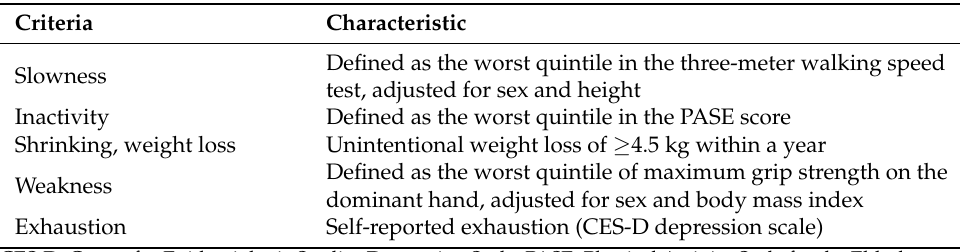
Table A1. Harmonized frailty assessment used in the FRAILOMIC Initiative.